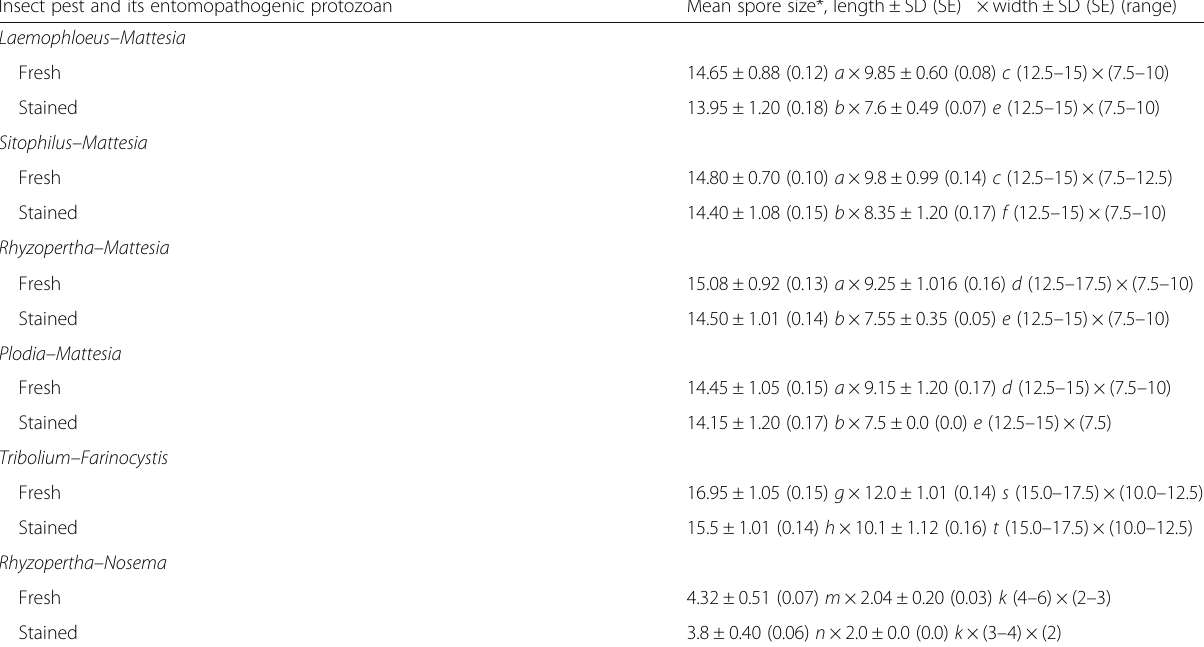
*Number of measured spores ranged between 50 and 60 spore. The difference in spore lengths or widths between fresh and stained spores are, in general, significant ( t test; significant at 5 or 1% level). Data followed by the same letter within column do not differ significantly at 1% level; Duncan ’ s multiple range test **Standard deviation of the mean (SD) and standard error